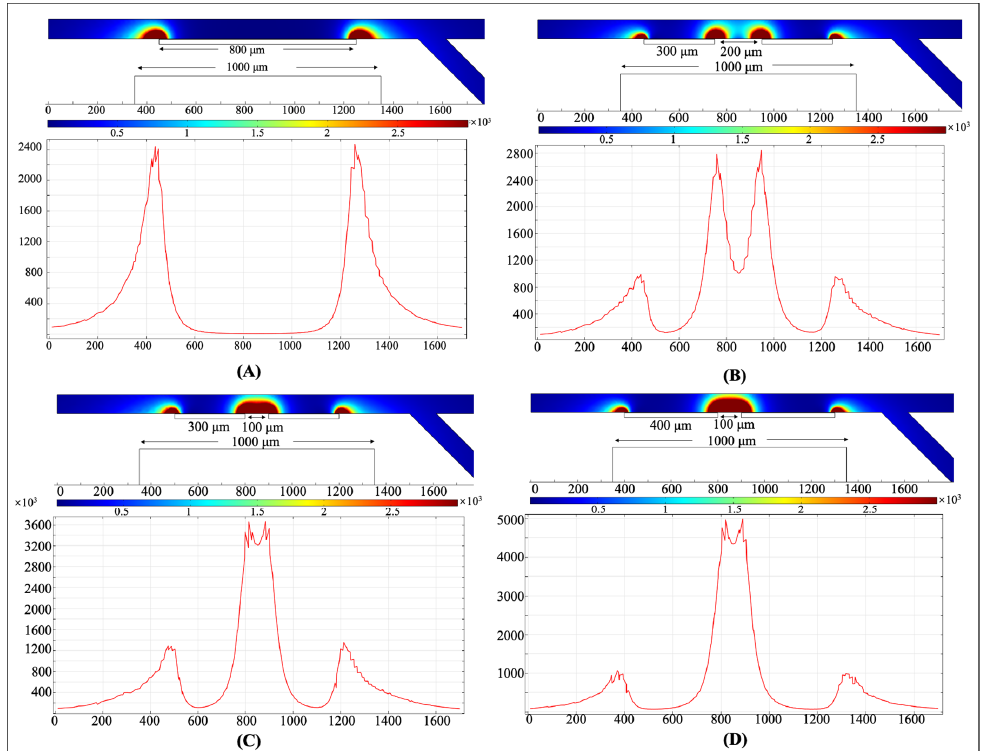
Figure 4. Numerical simulations of the effect of the ferromagnet structure on the gradient of the magnetic field. ( A ) Single-segment ferromagnet with a length of 800 μ m; double-segment ferromag- nets with ( B ) a length of 300 μ m and a distance of 200 μ m, ( C ) a length of 300 μ m and a distance of 200 μ m, and ( D ) a length of 400 μ m and a distance of 100 μ m. The length of the permanent magnet is 1000 μ m. The residual magnetic flux density is 1 T. The stronger magnetic field is depicted by the darker red color and higher magnitude.